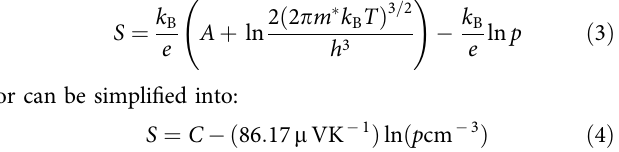
NATURE COMMUNICATIONS|8:16076|DOI: